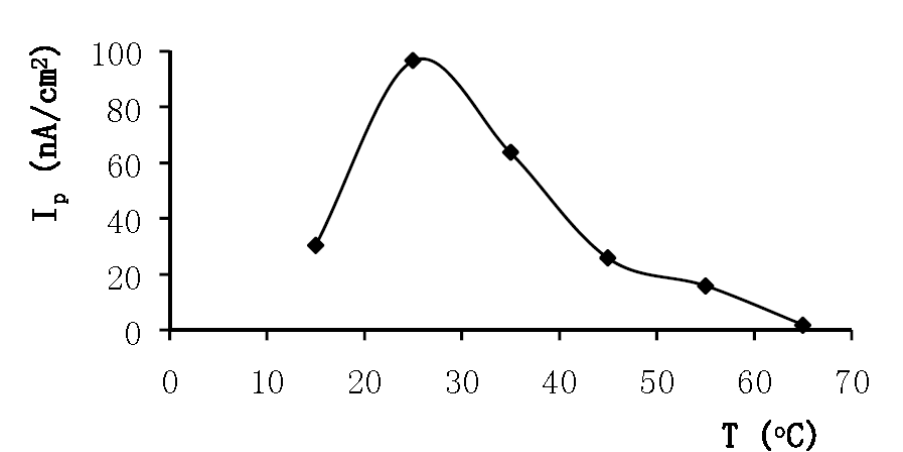
Figure 3. The effect of temperature on the biosensor response (phosphate buffer; pH 7.0, 50 mM, detection: DPV, scan rate: 15 mV/s , 2.0 × 10 −4 M ethanol).